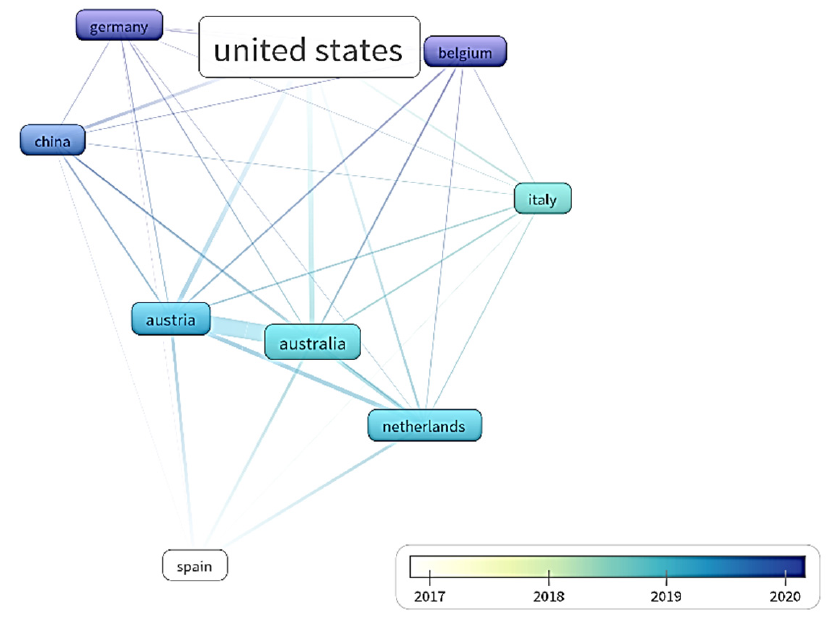
Figure 5. Links between countries in patent documents.